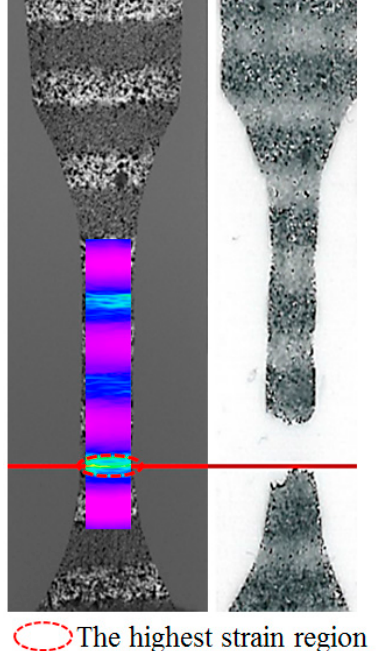
Figure 19. Comparison between the Y-direction strain measurement result with the highest strain (left) and the fracture position of specimen (right: black-and-white reversed image).